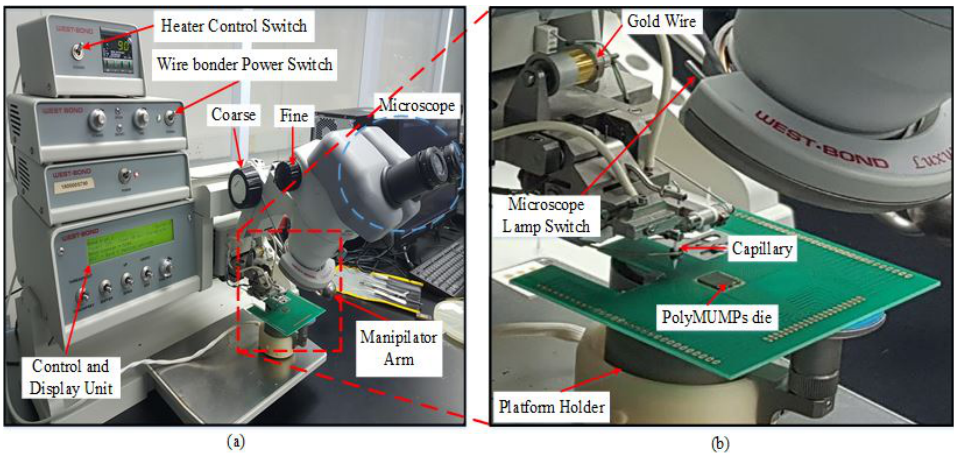
Figure 10. View of ( a ) WEST BOND gold wire-bonder model 7700E ( b ) side view of the gold-wire- bonding